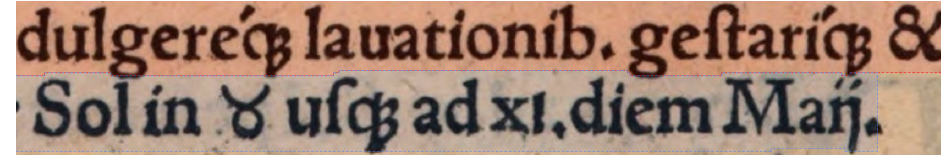
Figure 5. Example of a correct line segmentation in the Camerarius